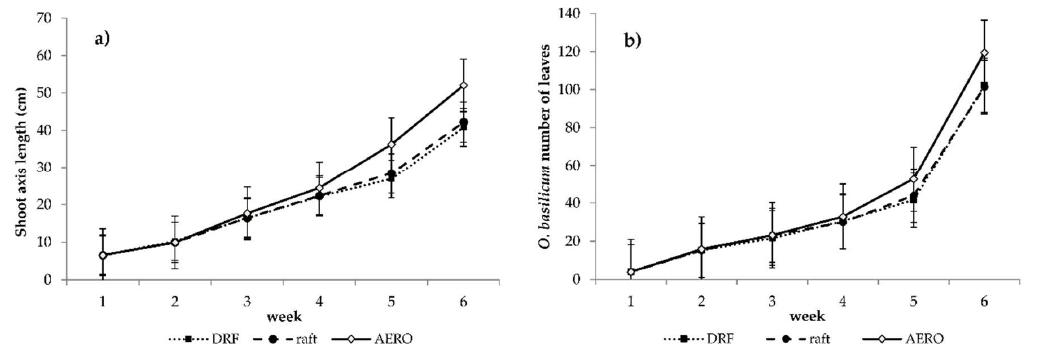
9 Figure 4. Average basil plants at the end of the experiment with visibly longer and finer roots and similar shoot growth performance in DRF ( left ) and raft ( middle ). Short but compact root growth and a better shoot growth performance in AERO ( right ). Shoot axis wet weight and shoot axis height differences were not significant in the DRF (12.48 g; 40.81 cm) and raft (12.22 g; 42.22 cm) and were significantly higher in AERO (17.93 g; 52.04 cm) (Figure 5). The root wet weight showed no statistical difference in the